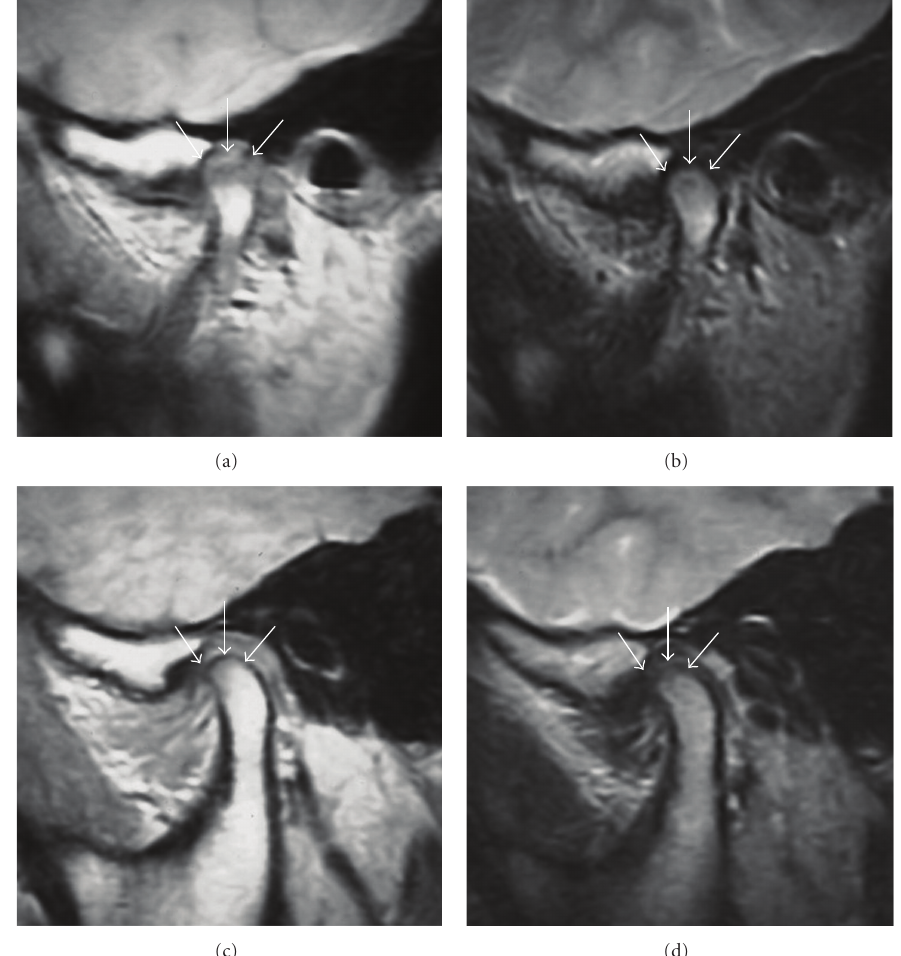
Figure 2: Alteration of mandibular condyles on MRI in growing schoolchildren over time. (a) DCLSs on the top of the mandibular condyles (arrows) appeared as high-intensity stripes over a low-intensity area on fast spin-echo intermediate-weighted images of a healthy 12-year-old boy at the first examination. The voided signal line at the top of the right mandibular condyle was not seen. The imaging parameters used in the MR sequences included 1050 ms TR, 15ms e ff ective echo time, flip angle of 90 ◦ , a 15 × 15cm field of view, a matrix of 160 × 288 pixels, 17mm slab thickness, and 3mm section thickness. (b) High-intensity stripes (arrows) were found to coincide with DCLSs on the top of the mandibular condyles; this was found using fast spin-echo T2-weighted images of the same subject as Figure 1(a). The imaging parameters used in the MR sequences included 3500 ms TR, 108ms e ff ective echo time, flip angle of 90 ◦ , a 15 × 15cm field of view, a matrix of 160 × 288 pixels, 17mm slab thickness, and 3 mm section thickness. (c) DCLS at the top of the left mandibular condyle, apparent at the first examination, had disappeared by the second examination three years later in the same subjects as Figures 1(a) and 1(b). The imaging parameters used in the MR sequences included 1050 ms TR, 15ms e ff ective echo time, flip angle of 90 ◦ , a 15 × 15cm field of view, a matrix of 160 × 288 pixels, 17mm slab thickness, and 3mm section thickness. (d) High-intensity stripes (arrows) were not seen at the top of the mandibular condyles at the second examination three years after the first one in the same subjects as Figures 1(a), 1(b), and 2(a). The imaging parameters used in the MR sequences included 3500 ms TR, 108ms e ff ective echo time, flip angle of 90 ◦ , a 15 × 15cm field of view, a matrix of 160 × 288 pixels, 17 mm slab thickness, and 3mm section